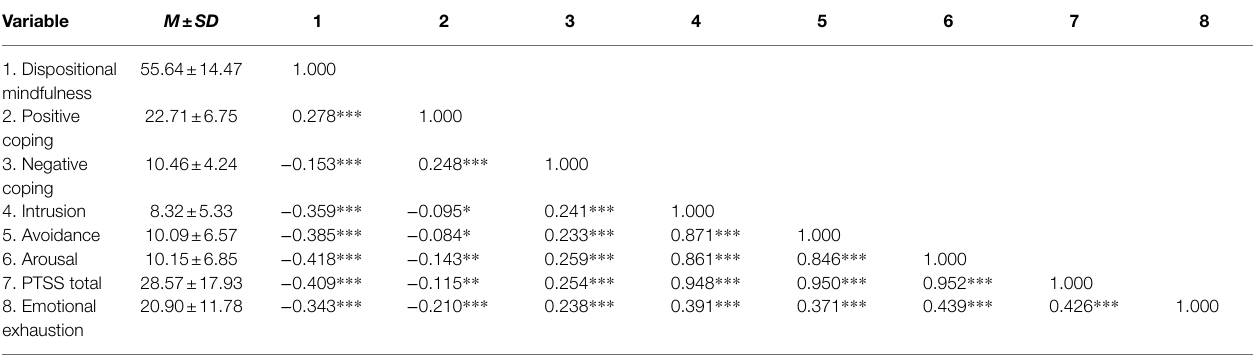
TABLE 1 | Means, SDs, and Spearson’s correlations among study variables ( n = 571). Variable M ± SD